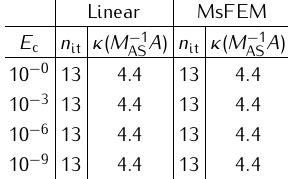
Table 6. Iteration numbers n and condition numbers κ ( M − 1 A ) for Experiment 3; geometry: 1 /h× 1 /h×H/h , h = 1 / 240 , H = 12 h ; linear and it AS multiscale coarsening for different contrasts E